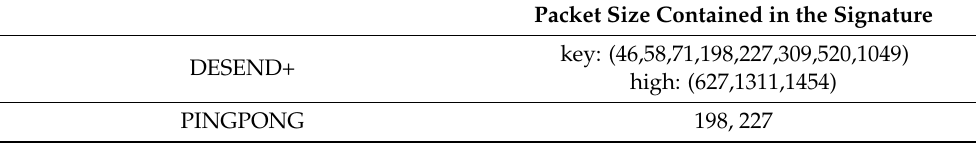
Table 1. TP-LINK bulb ON-event.